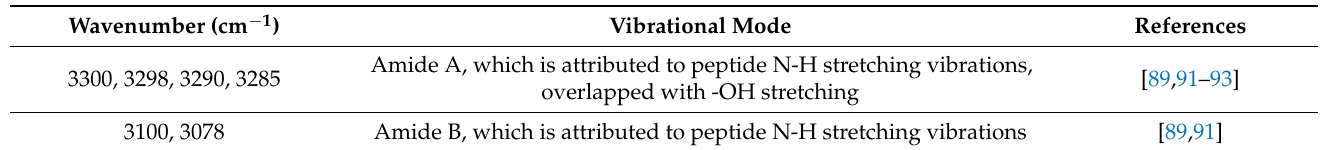
Table 2. Assignments of prominent peaks observed in biological IR